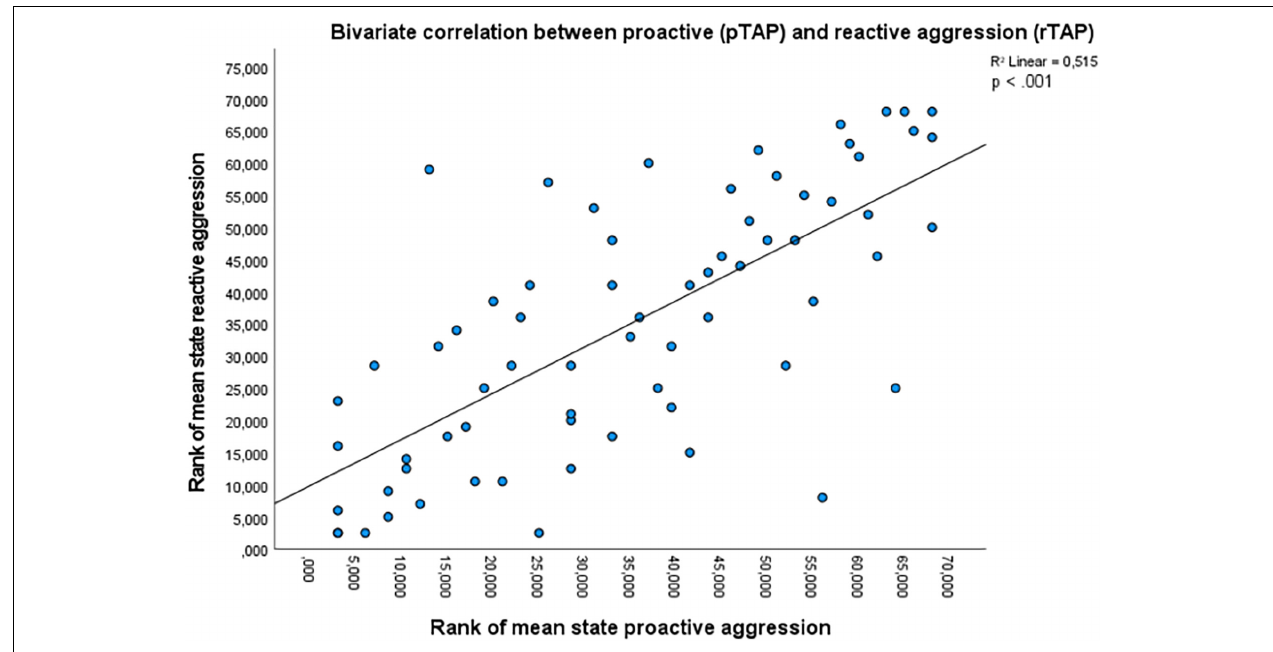
FIGURE 2 | A scatter plot representing the bivariate correlation between the rank of the mean levels of state proactive aggression (pTAP) and of state reactive aggression (rTAP).